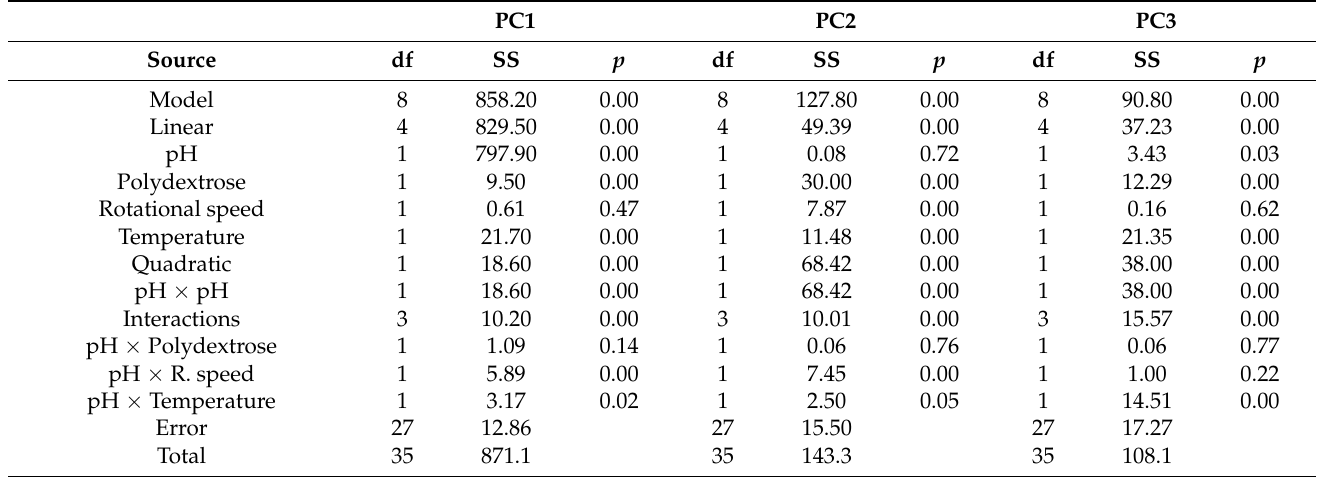
Table 6. Analysis of variance for each component with linear and quadratic functions and interactions among pH, polydextrose concentration, rotational speed, and temperature.